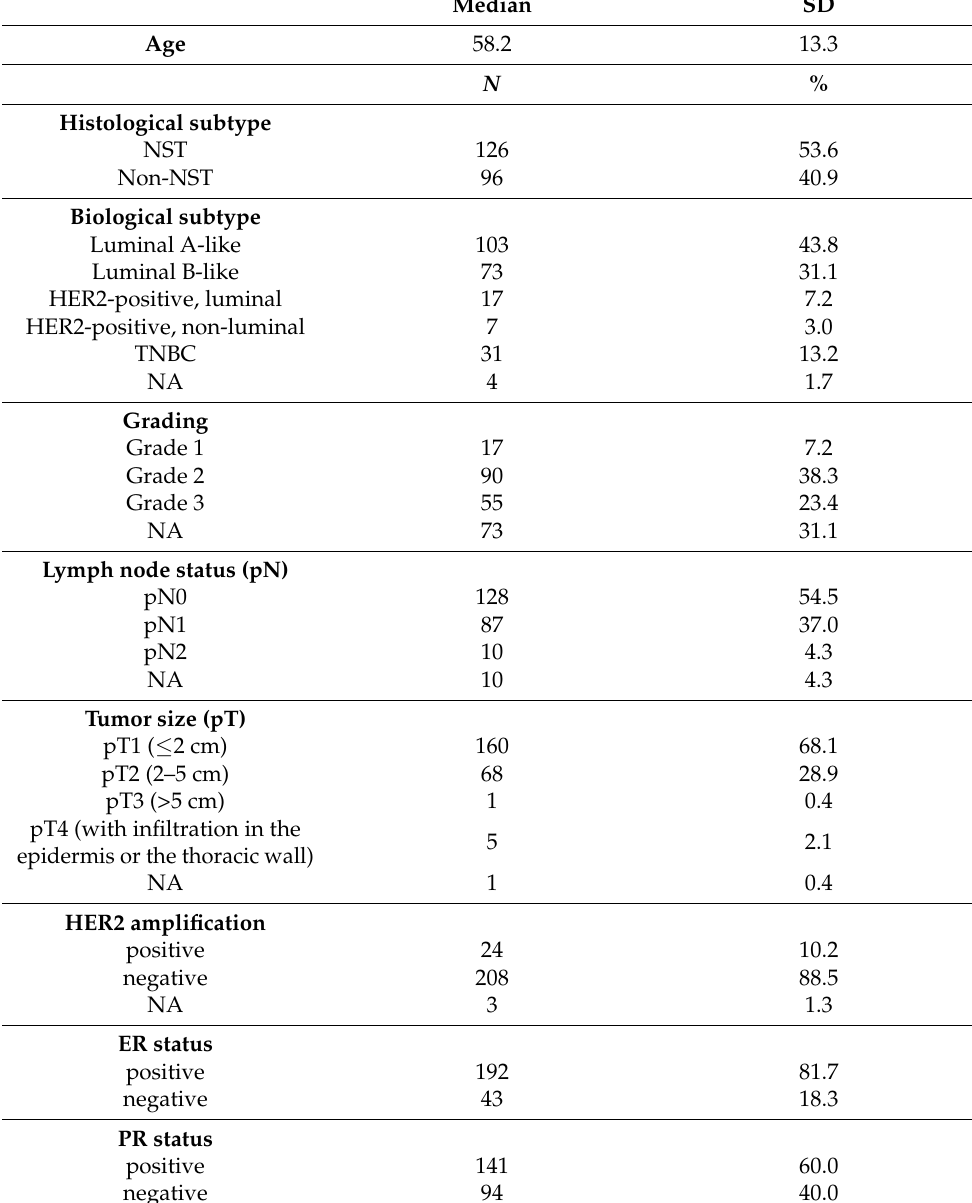
Table 2. Patients’